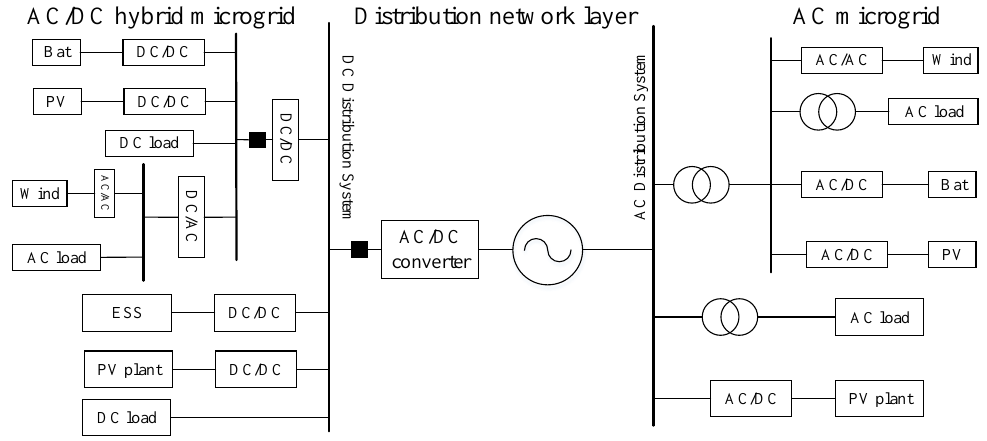
Figure 5. Basic structure of a regional power system.